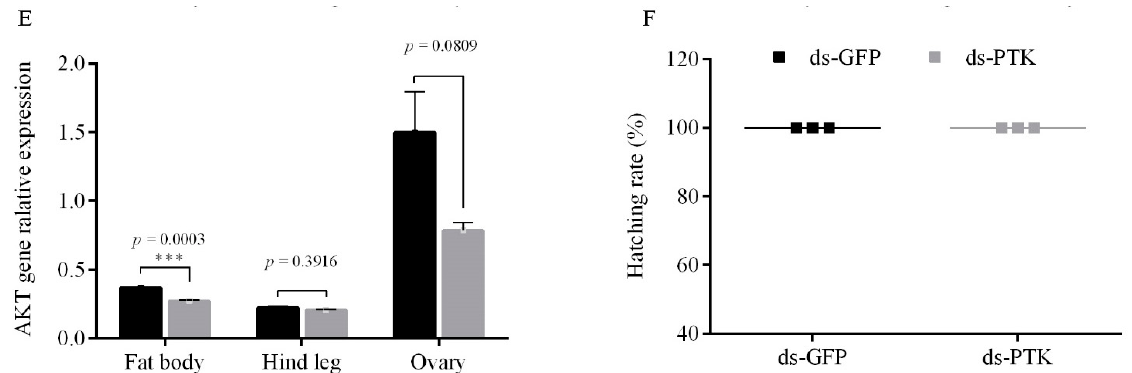
Figure A3. Gene relative expression and egg hatching incidence after injection of adults with RNAi PTK compared to GFP (control) under long photoperiod conditions (L16:D8) for ( A ) PTK gene, ( B ) IR gene, ( C ) IRS gene, ( D ) PI3K gene, ( E ) AKT gene and ( F ) egg hatching incidence. Data are the mean ± SEM from three independent replicates, the gray bar indicates RNAi treatments, while the black bar indicates GFP controls (* p < 0.05, ** p < 0.01, and *** p < 0.001 vs. GFP controls, Student’s t -test).